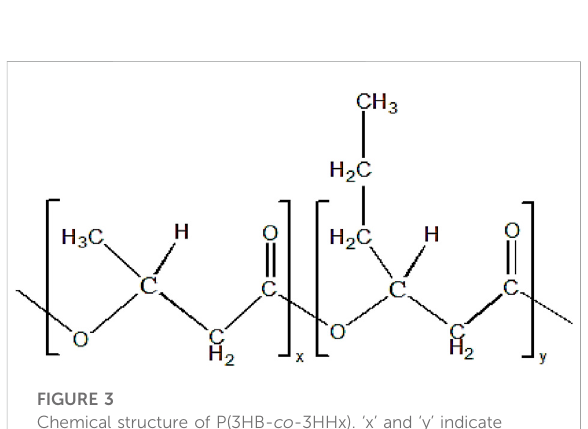
FIGURE 3 Chemical structure of P(3HB- co -3HHx). ‘ x ’ and ‘ y ’ indicate the repeating units of monomer.